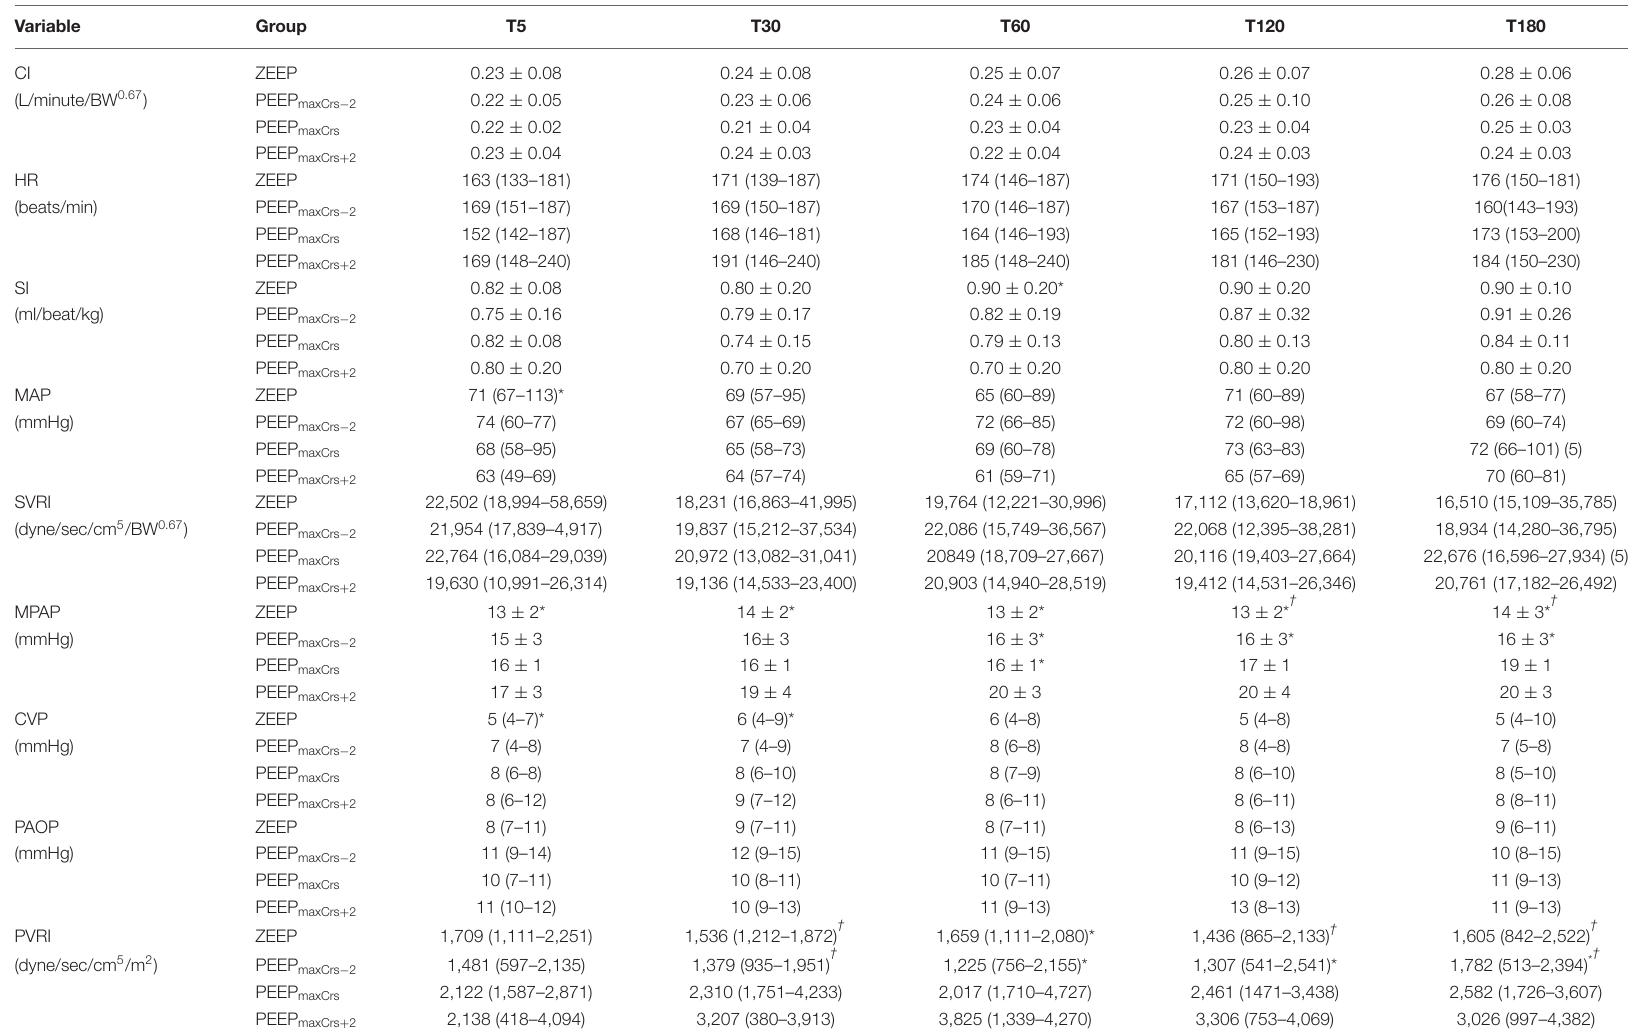
TABLE 3 | Selected cardiovascular variables in six (unless indicated within parenthesis) isoflurane-anesthetized cats mechanically ventilated for 3h with a tidal volume of 10 ml/kg and four end-expiratory pressure (EEP) treatments: zero end-expiratory pressure (ZEEP), positive end-expiratory pressure (PEEP) of highest respiratory system compliance (PEEP maxCrs ), PEEP maxCrs minus 2 cmH 2 O (PEEP maxCrs − 2 ), and PEEP maxCrs plus 2 cmH 2 O (PEEP maxCrs + 2 ).